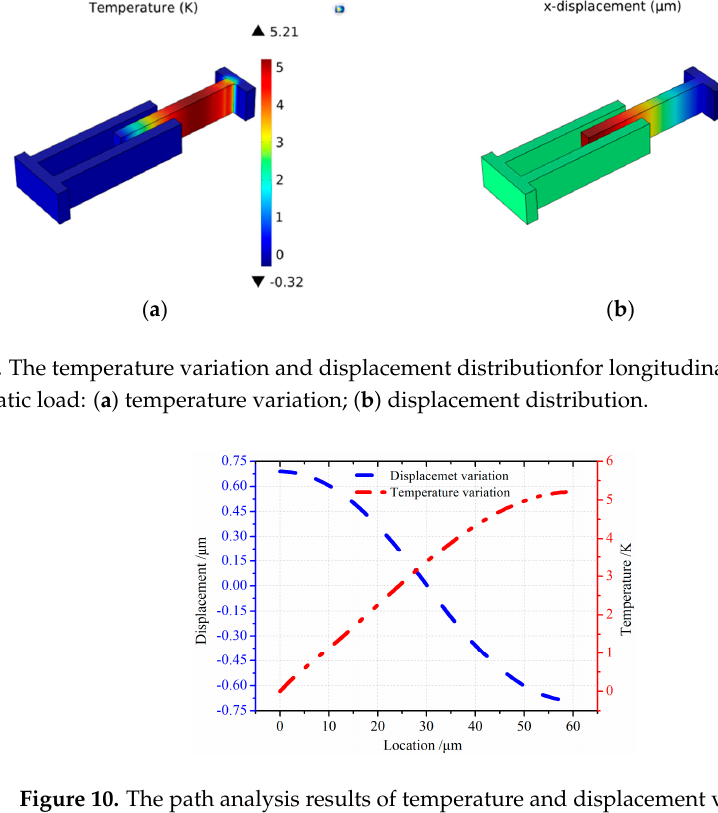
( b ) Figure 11. The temperature variation and displacement distribution for transverse vibration: ( a ) temperature variation; ( b ) displacement distribution. Figure 12. The path analysis results of temperature and displacement variation. Table 2. Field quantities simulation and analytical comparison results for vibration at drive-mode and sense-mode.